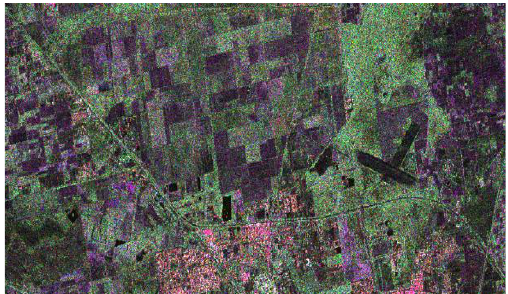
Figure 1: Composite of HH, HV and VV bands of Hisar